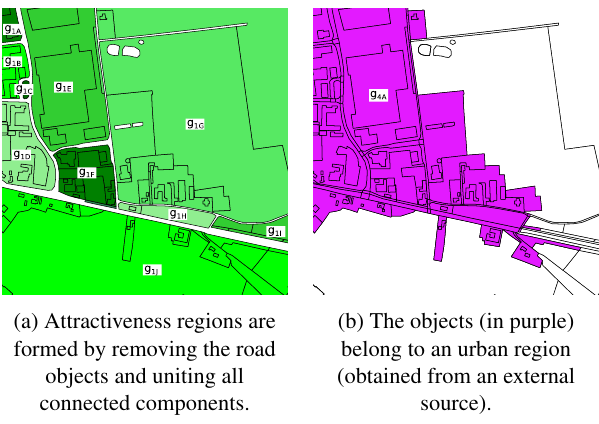
Table 3. Example of a scale dependent compatibility matrix.